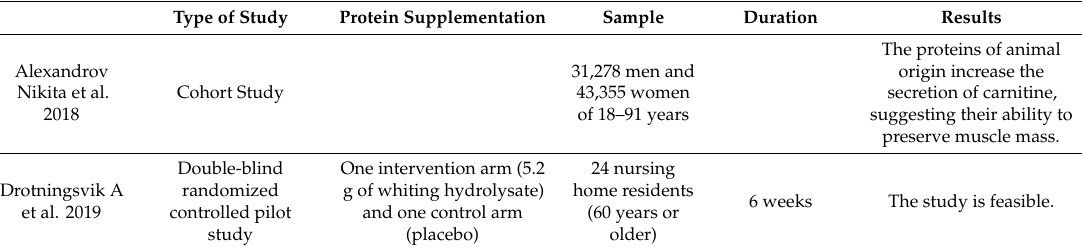
Table 2. Summary of studies on fish protein considered in this narrative